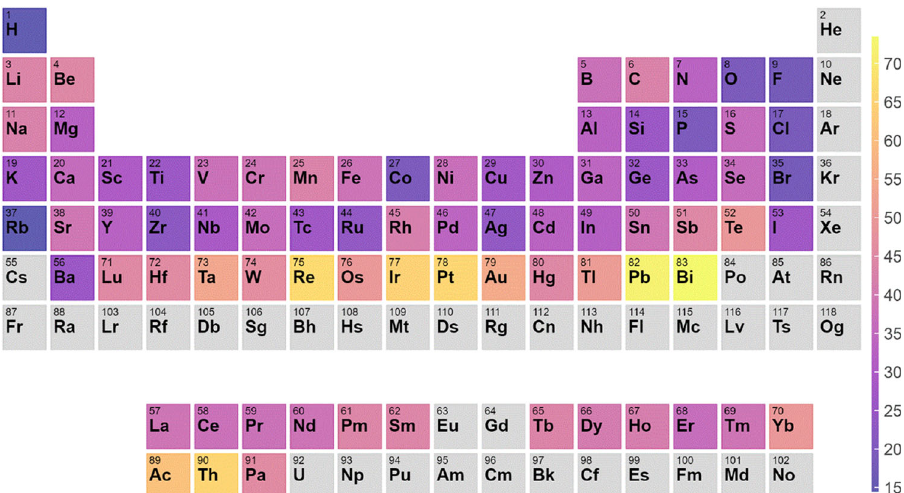
Fig. 2 Example of Density Functional Theory used to predict topological properties of materials. Periodic table trend showing the percentage chance (color coded) that a compound containing any given element can be topologically nontrivial based on spin-orbit spillage approach, based on spillage data for 4835 nonmagnetic materials (reproduced from ref. 68 under the terms of the Creative Commons CC BY license). The spillage is a machine-learnable quantity, and an accurate classi fi cation model predicting it (utilizing gradient boosting decision trees) was developed in ref. 73